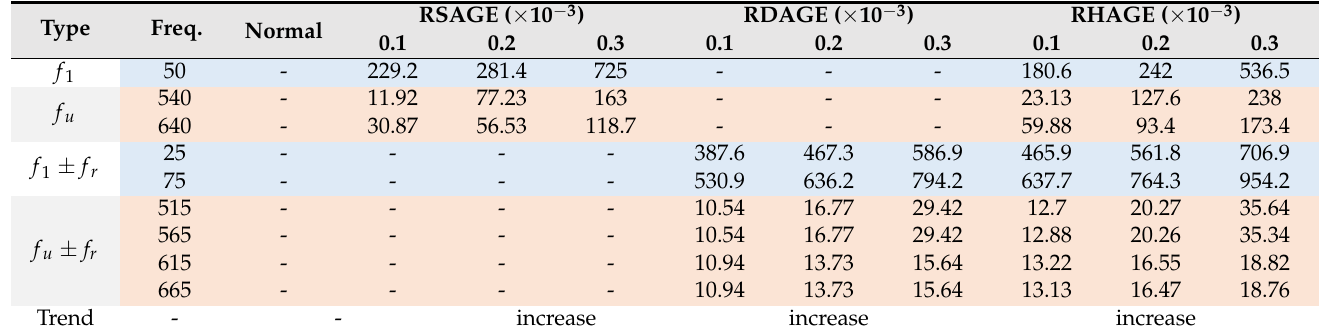
Table 7. Experiment results of